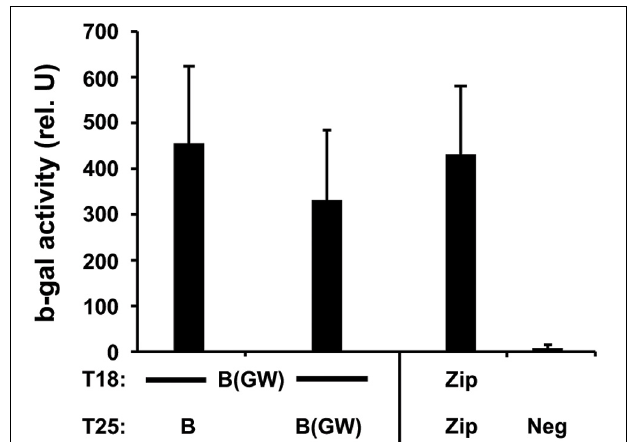
FIGURE 1 | Interactions of chlamydial MreB with itself. Interaction assays of the indicated MreB hybrids expressed from either the Gateway® (GW) or the standard BACTH vectors. (cid:2) cya E. coli DHT1 were co-transformed with the indicated constructs and plated on selective medium containing IPTG and X-gal. ß-galactosidase (ß-gal) activity was measured from eight colonies per test condition per experiment, with at least two experiments performed, after overnight culture in selective medium with IPTG and is expressed as pooled average relative units with standard deviation. A positive interaction is considered if the test interaction has 5-fold greater activity compared to negative controls. The positive control of T25-Zip and T18-Zip was used. Neg = negative control consisting of pooled data from tests of constructs vs. empty vectors or unrelated chlamydial inner membrane proteins, Ct471 or